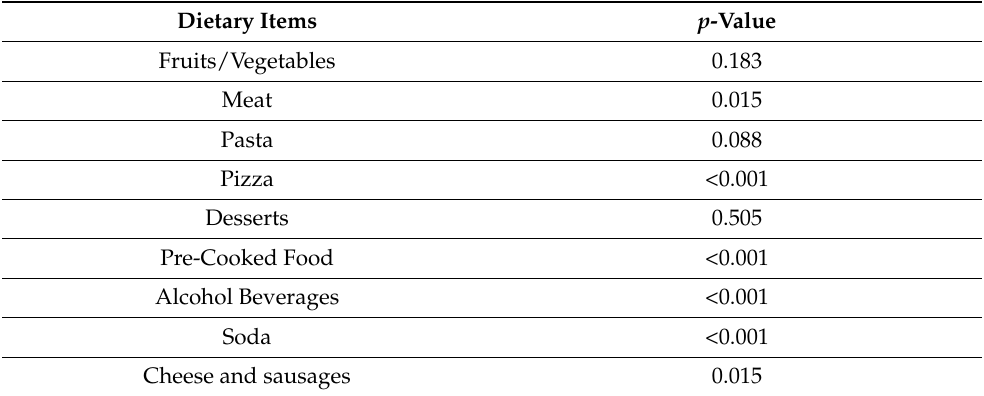
Table 7. Correlation between dietary habits before and during the SARS-CoV-2 lockdown period.